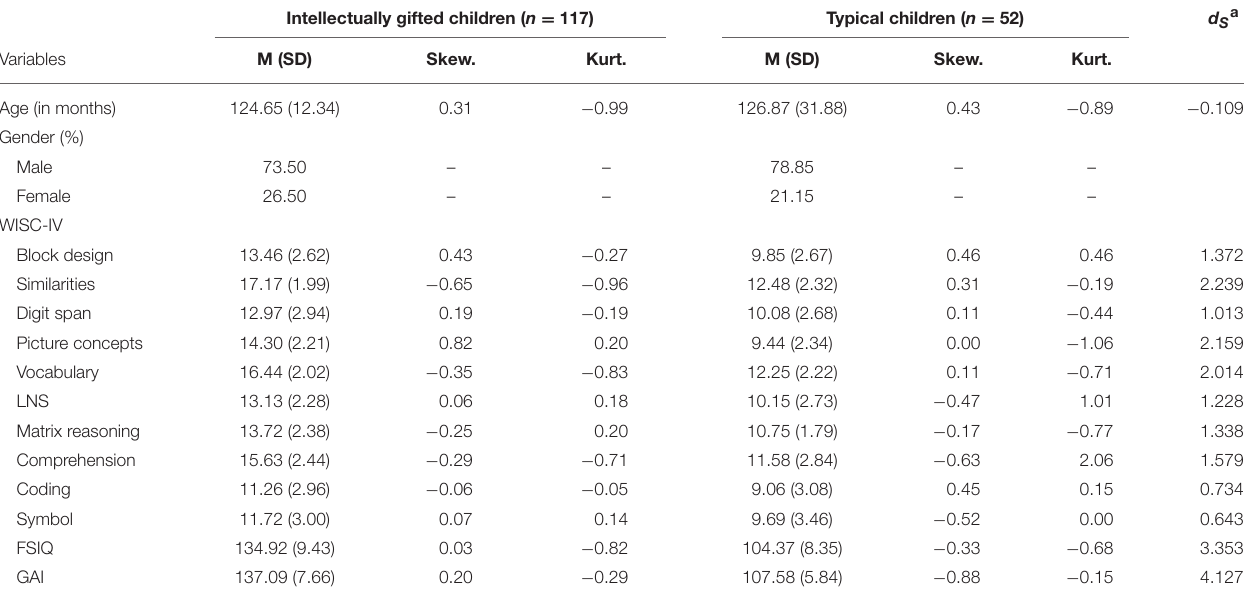
TABLE 1 | Descriptive statistics of the